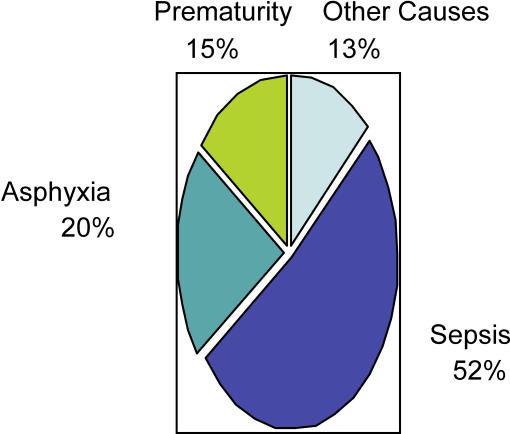
Causes of Neonatal Mortality in India (Adapted from [1])